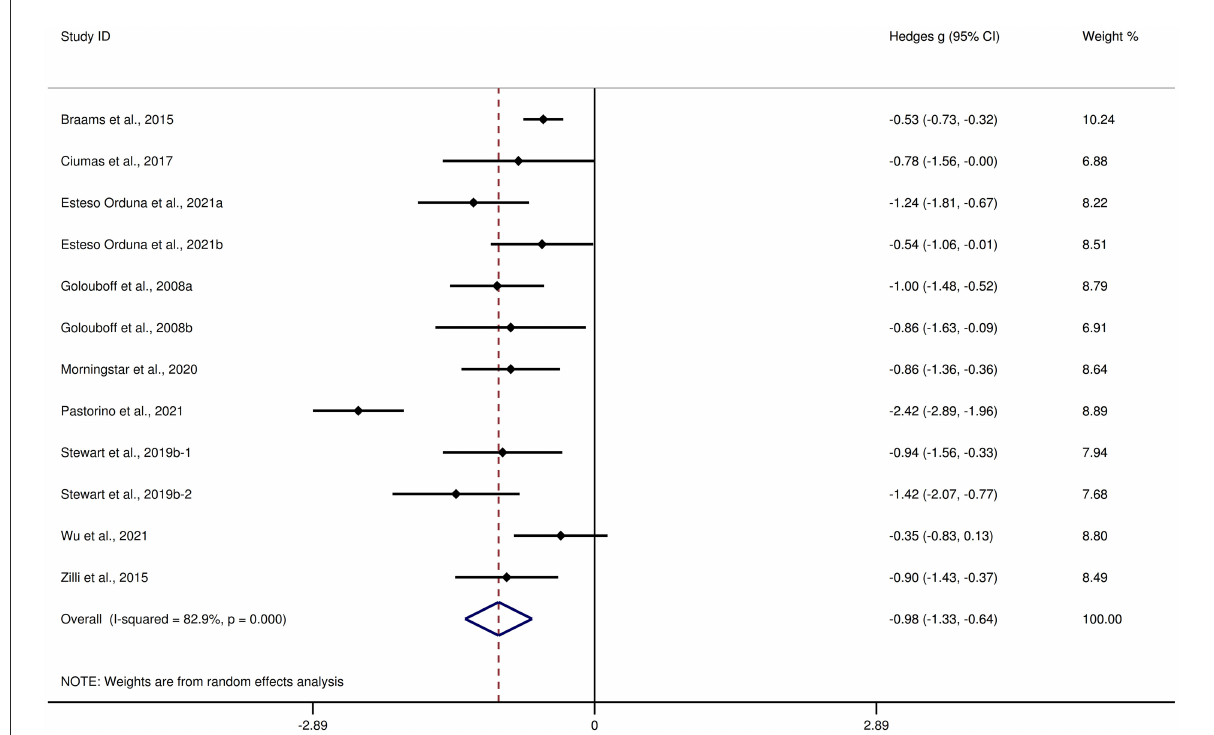
FIGURE3 Forest plots showing effect size estimates for FER differences between children and adolescents with epilepsy and healthy